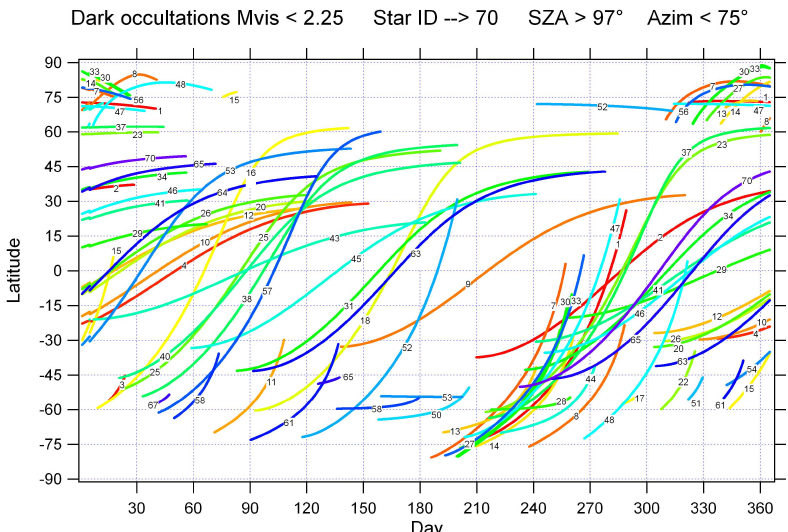
Fig. 7. Each coloured curve represents the occultation point latitude as a function of the day of the year (DOY) from the ENVISAT orbit. The number is the GOMOS star identification number, ordered by increasing visual magnitude. Only occultations in dark limb conditions, and with an azimuth angle < 75 ◦ are represented. Scintillations have a greater effect on transmission spectra for larger azimuth angles. The pattern repeats identically every year.